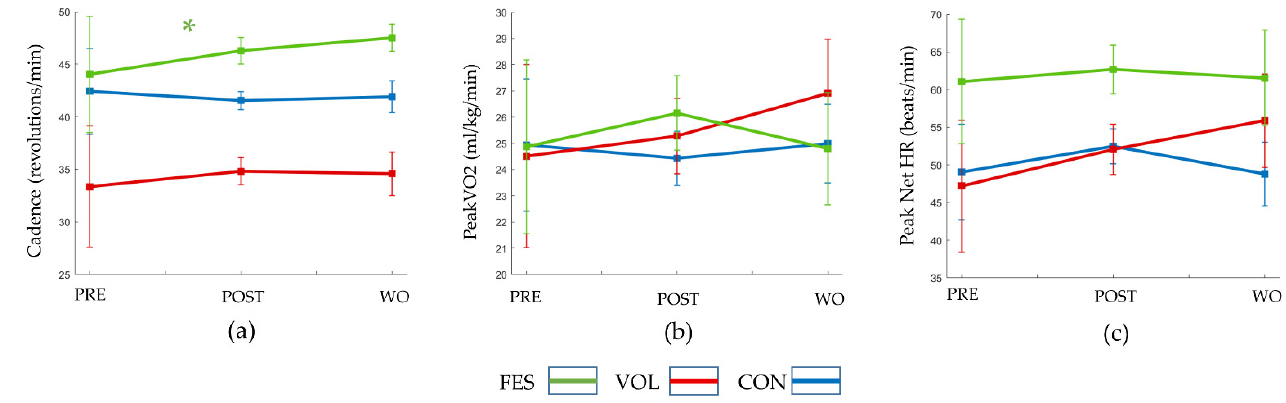
Figure 2. Cardiovascular performance during incremental test in the functional electrical stimulation-assisted cycling (FES), volitional cycling (VOL), and control (CON) groups. The graphs depict the slope of the ( a ) cadence, ( b ) peak VO 2, and ( c ) peak net HR across PRE to POST and POST to washout (WO) time points. Error bars depict standard error of the mean at the three time points.